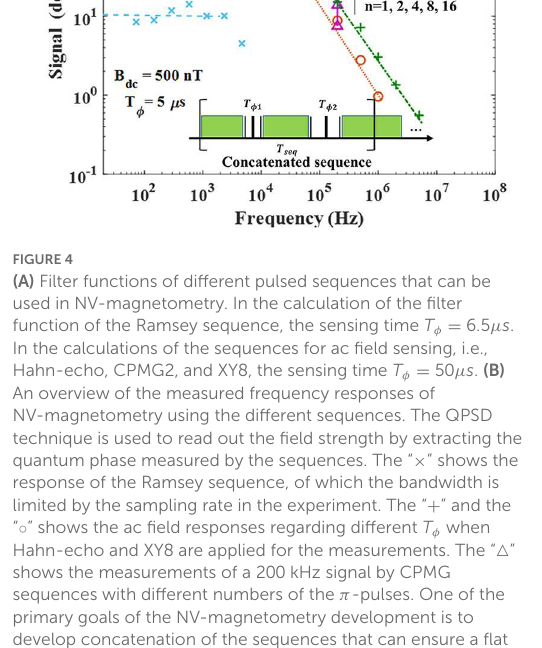
6.5 µ s . = 50 µ s . (B) = ” shows the × ” and the + ” △